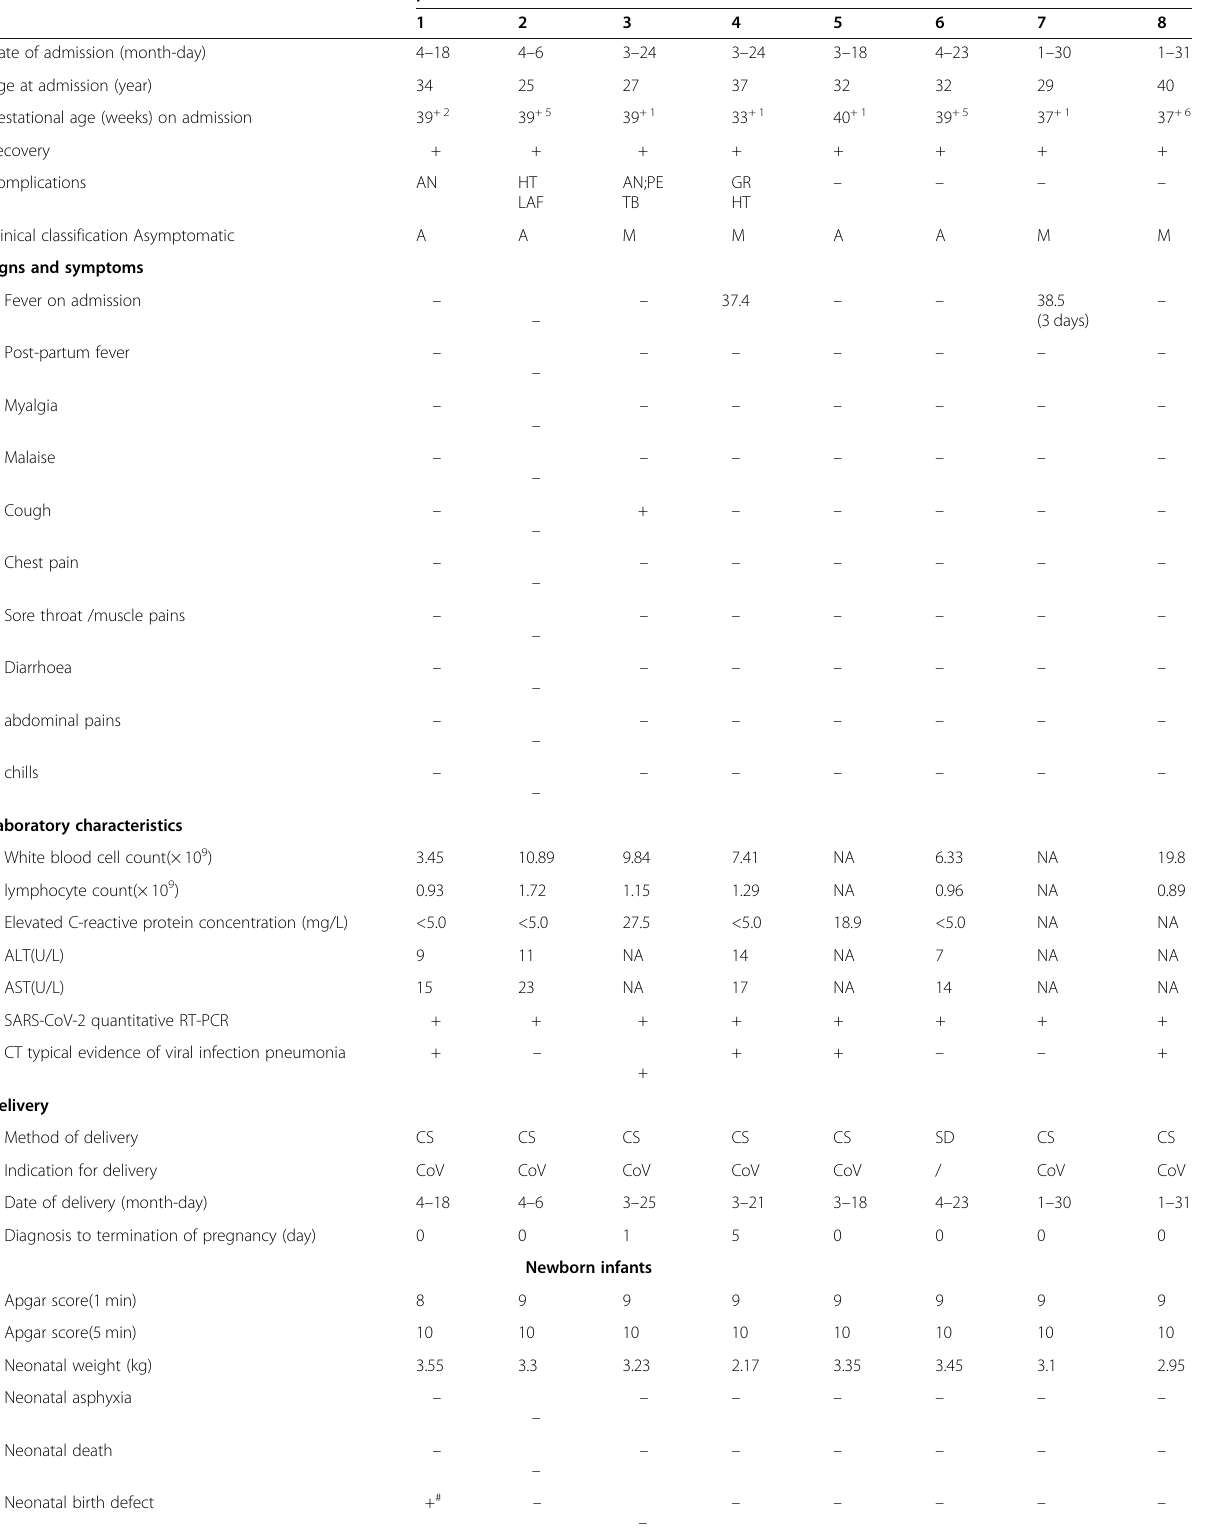
Table 1 Demographical and clinical characteristics of the recovered COVID-19 infected pregnant women